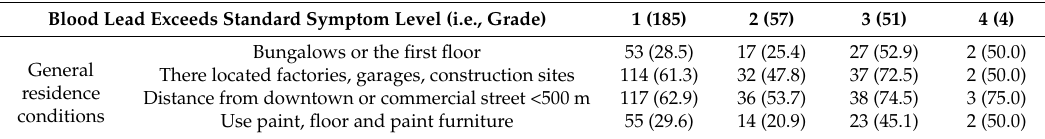
Table 14. The relationship between general residence conditions and